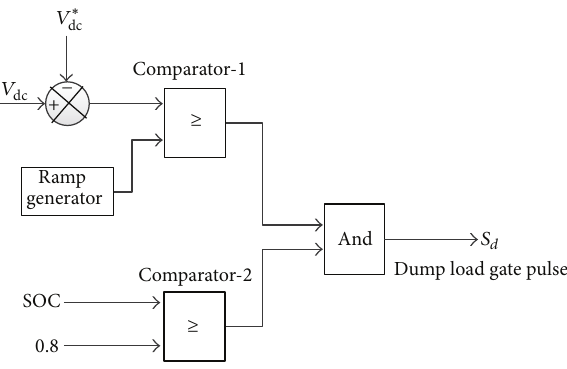
Figure 13: The schematic diagram of dump load controller.